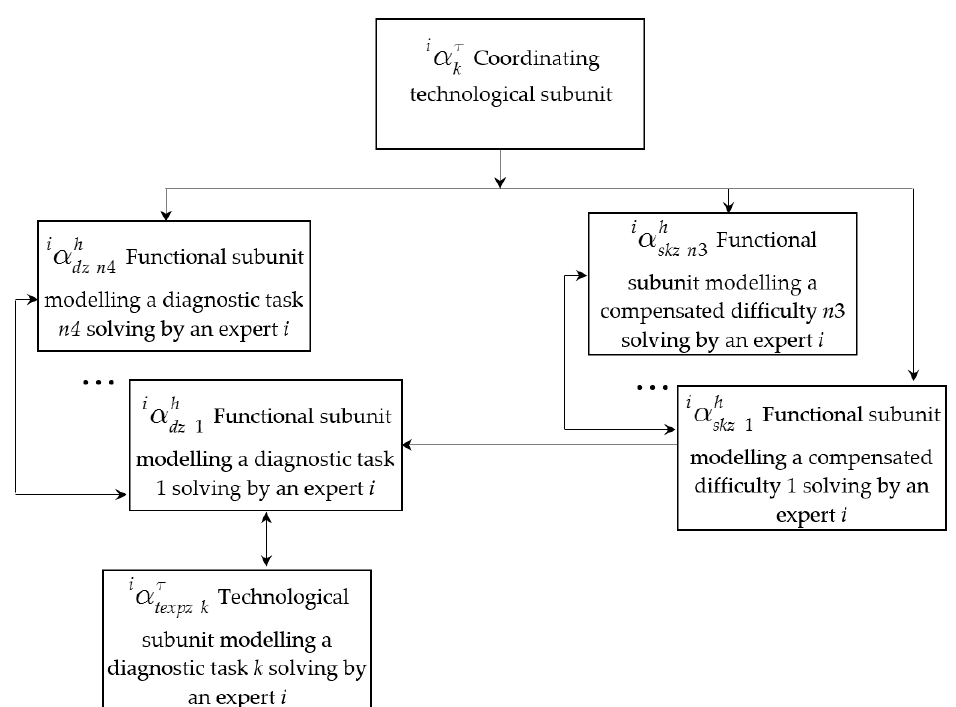
Figure 4. Complex functional element modeling a diagnostic subproblem solving by an expert. Typical structure.